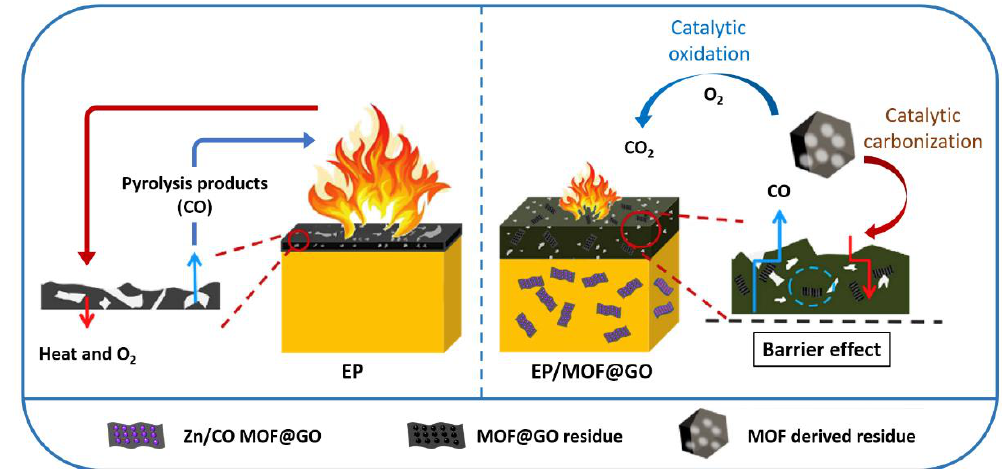
Figure 28. Proposed flame-retardant process of EP/MOF@GO nanohybrids. Reprinted with permission from Ref. [195]. Copyright 2020, Elsevier.